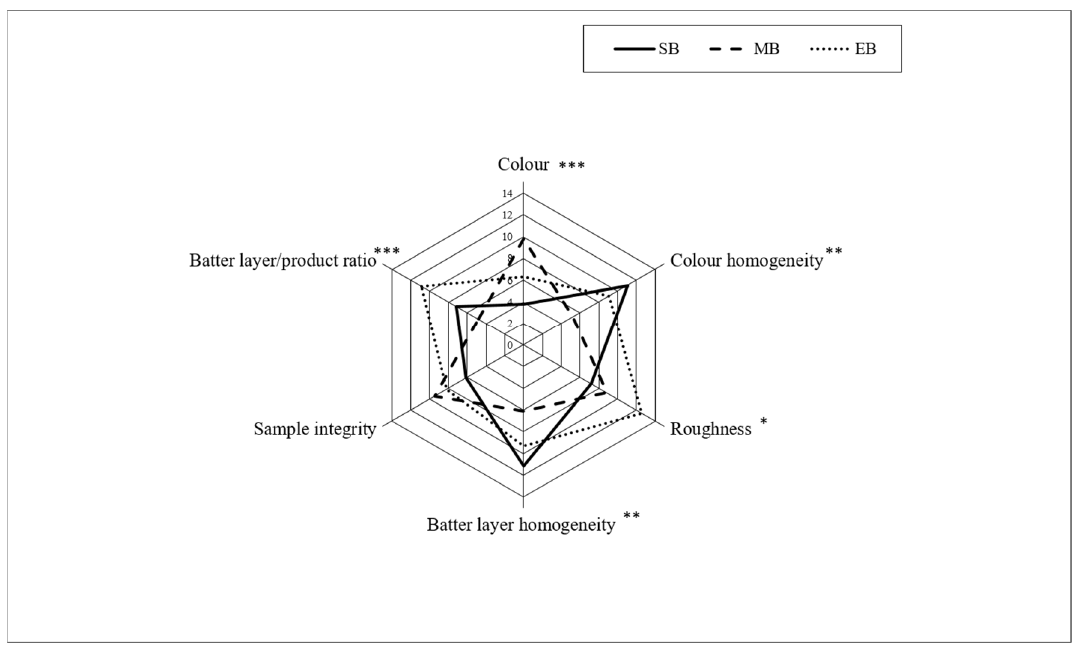
Figure 2. Results of the sensory analysis of the external characteristics of fried samples ( n = 30). SB: standard batter; MB: maltodextrin batter; EB: ethanol batter. Color SEM = 1.02; Color homogeneity SEM = 1.01; Roughness SEM = 0.92; Batter layer homogeneity SEM = 0.89; Sample integrity SEM = 0.72; Batter layer/product ratio SEM = 0.90. Significant differences between samples are expressed by * p < 0,05; ** p < 0.01; *** p < 0.001.